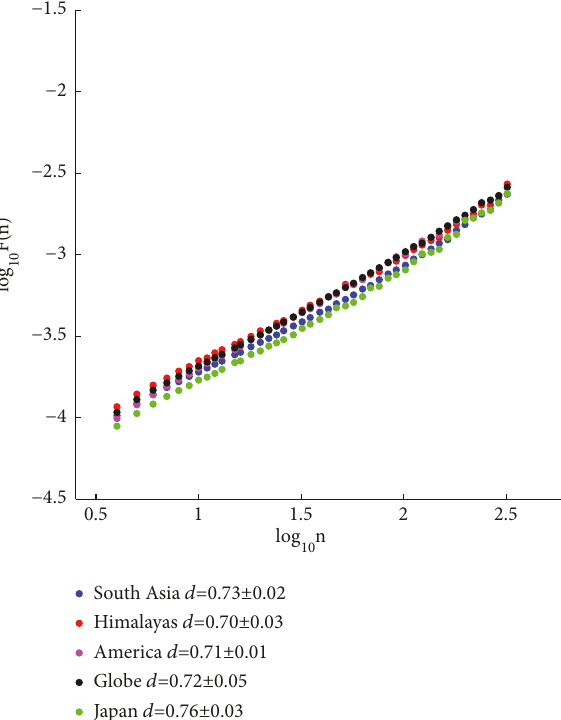
Figure 2: log 10 𝐹(𝑛) -log 10 𝑛 plots for the time series of hypocenter separation distance in catalogs: South Asia, Himalayas, America, Globe, and Japan. The employed method for calculations is the general DFA.